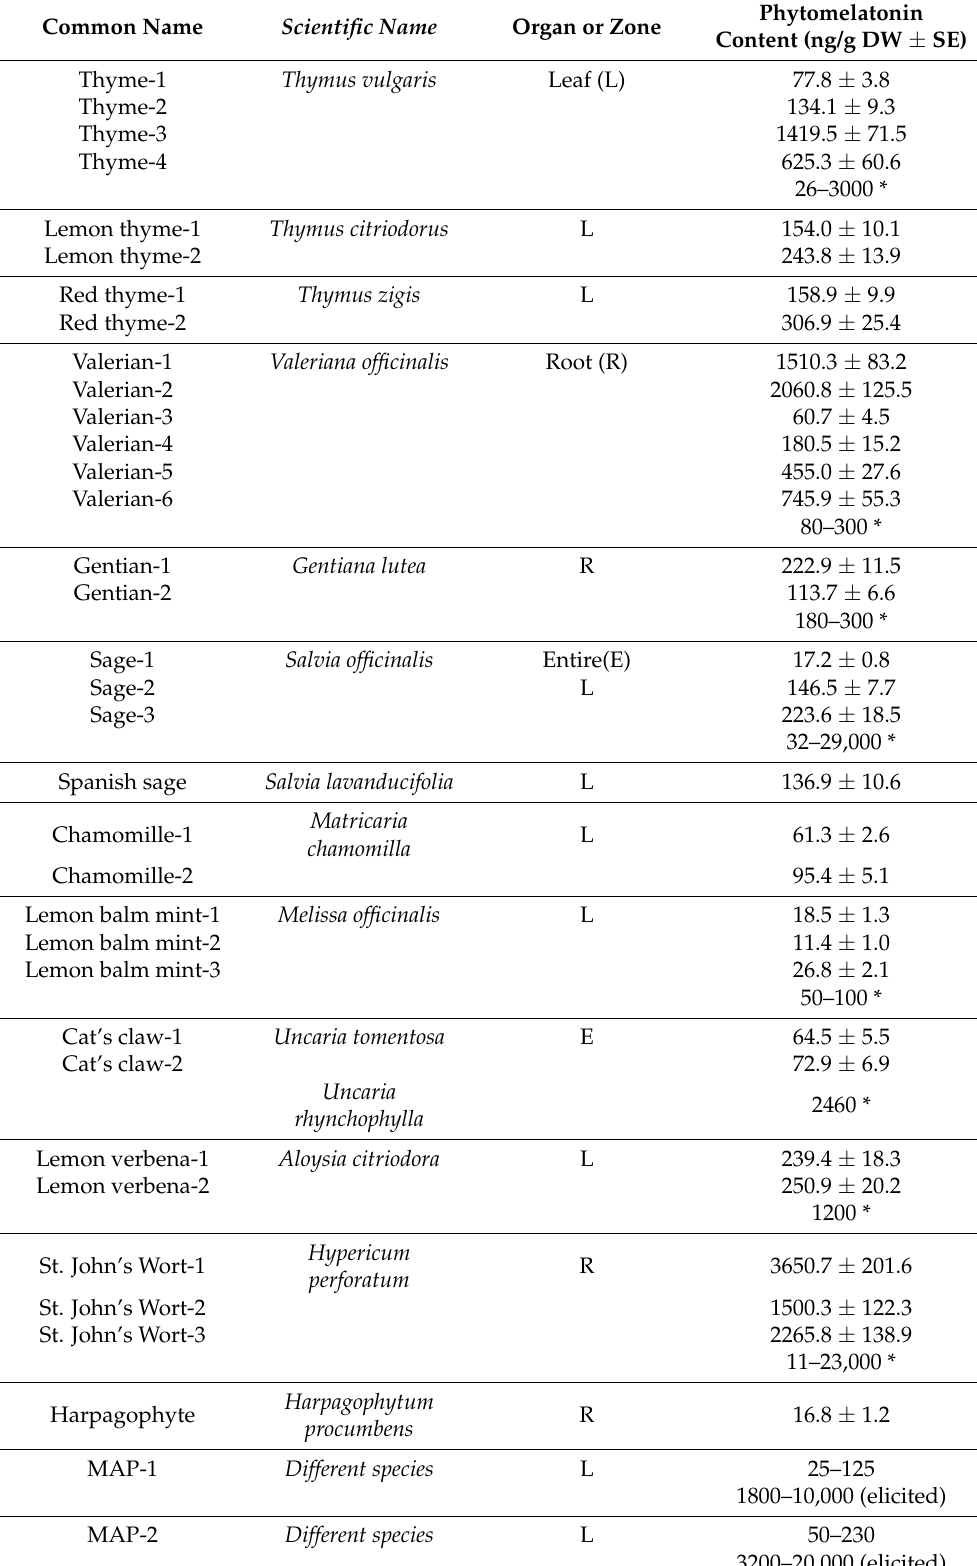
Table 2. Phytomelatonin content of different medicinal-aromatic plants (MAPs) from different origin, sources, and harvest. Data reported in